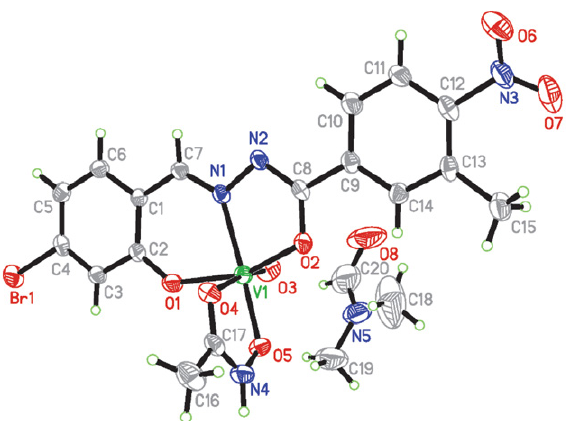
Fig. 1. ORTEP diagram of complex 1 with 30% thermal ellipsoid. Table 3. Hydrogen bond distances (Å) and bond angles (°) for the complexes D– H∙∙∙ A